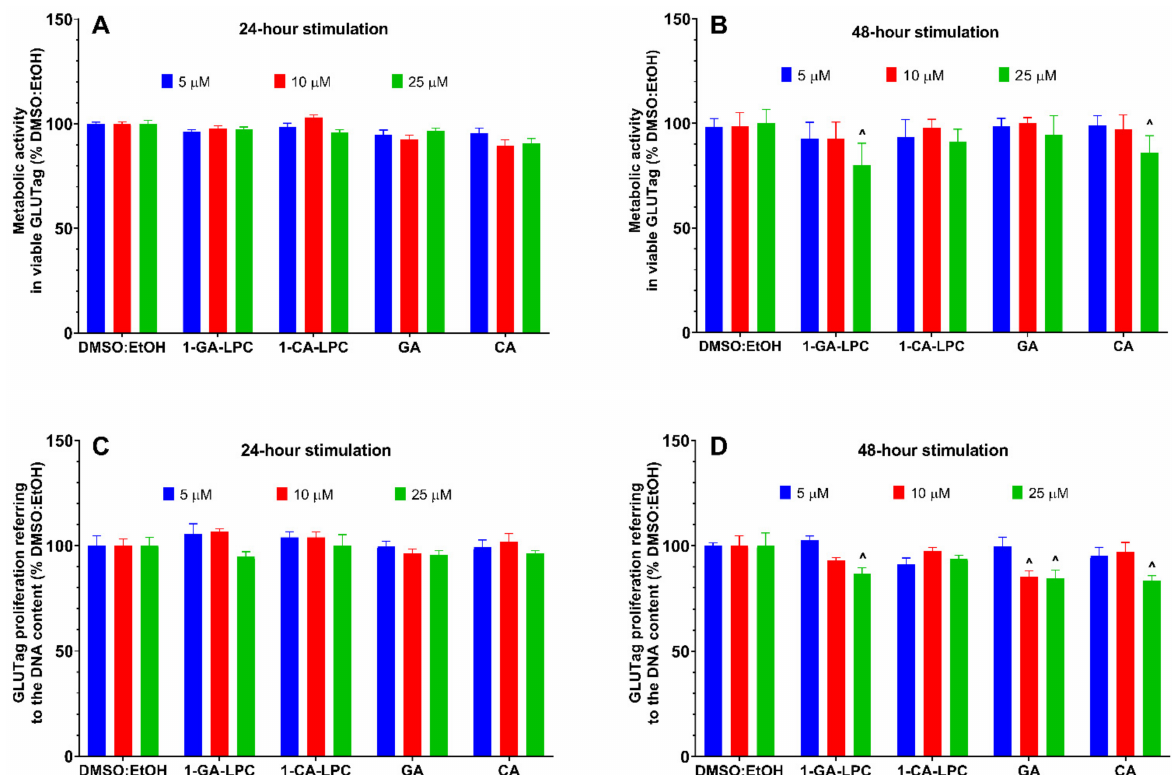
Figure 7. GLUTag cells viability after 24 h ( A , C ) and 48 h ( B , D ) treatment in fasting conditions with 1-GA-LPC and 1-CA-LPC and their corresponding acids (GA, CA). Cytotoxicity was assessed in the range of 5–25 µ M concentrations, based on the activity of mitochondrial reductases with the PrestoBlue TM Cell Viability Reagent ( A , B ), and referring the number of living cells to the quantity of DNA with the CyQUANT TM Cell Proliferation Test ( C , D ). The results are presented as means ± SEM from 3-4 independent experiments, 3-6 biological replicates each, and expressed as % of living cells after treatment with respective compounds solvent (DMSO:EtOH). ˆ p < 0.05 is considered as significantly different from